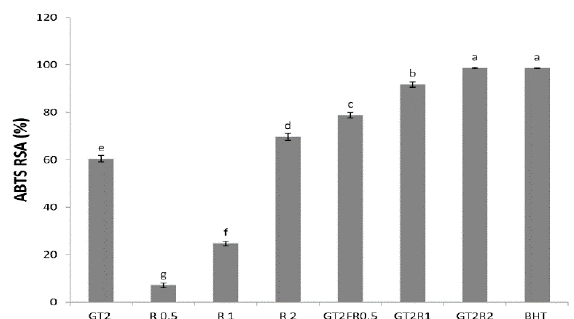
Fig. 3. ABTS Radical Scavenging Activity of Green Tea, R. damascena, and their infusions (Small letters show significant differences [P<0.05] among the ABTS scavenging activity of the samples; BHT (2 mg/ml) as the positive control)